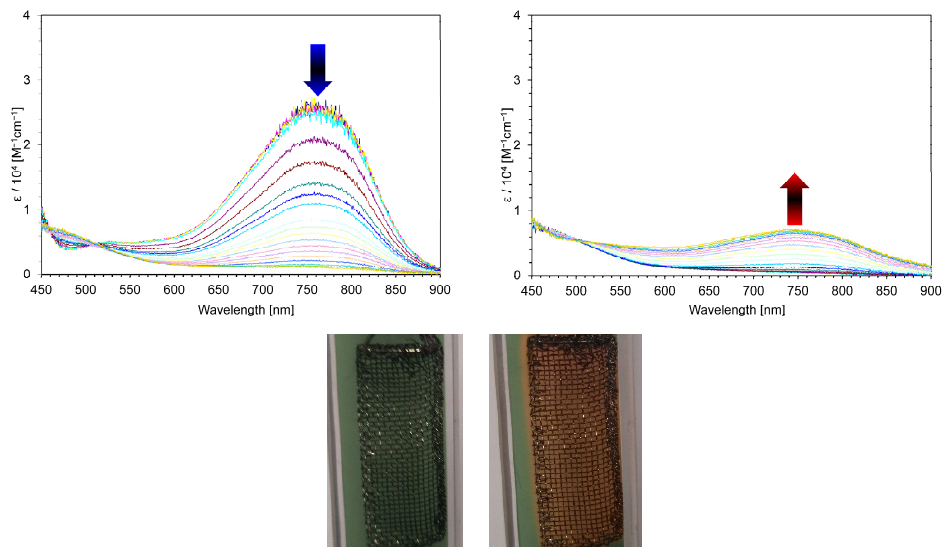
Figure 9. Continuous change in visible spectra of 3a + · PF 6 − in benzonitrile containing Et 4 NClO 4 (0.1 M): constant-current electrochemical reduction (50 μ A) at 30 sec intervals ( left ) and the reverse oxidation ( right ) of the reduced species (50 μ A) at 30 sec intervals. Photo: Color changes of 3a + ·PF 6 − upon the electrochromic analysis in benzonitrile containing Et 4 NClO 4 (0.1 M) (50 μ A); before electrochemical reduction ( left ) and after electrochemical reduction ( right ).